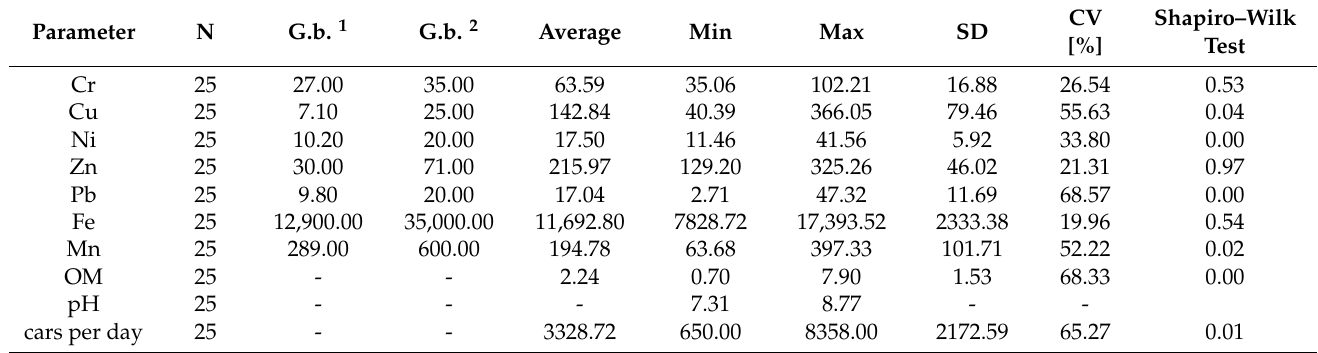
Table 1. Descriptive statistics of metal concentrations (mg · kg − 1 ) in Suwałki road